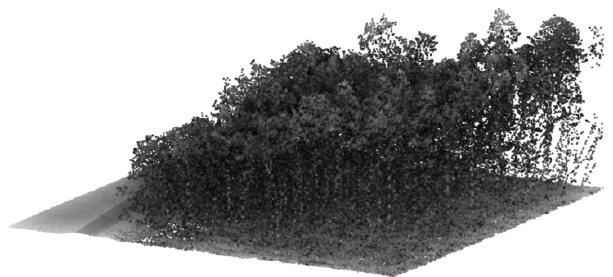
Figure 13. Return pulse intensities for a young forest shown in greyscale for the sample area.